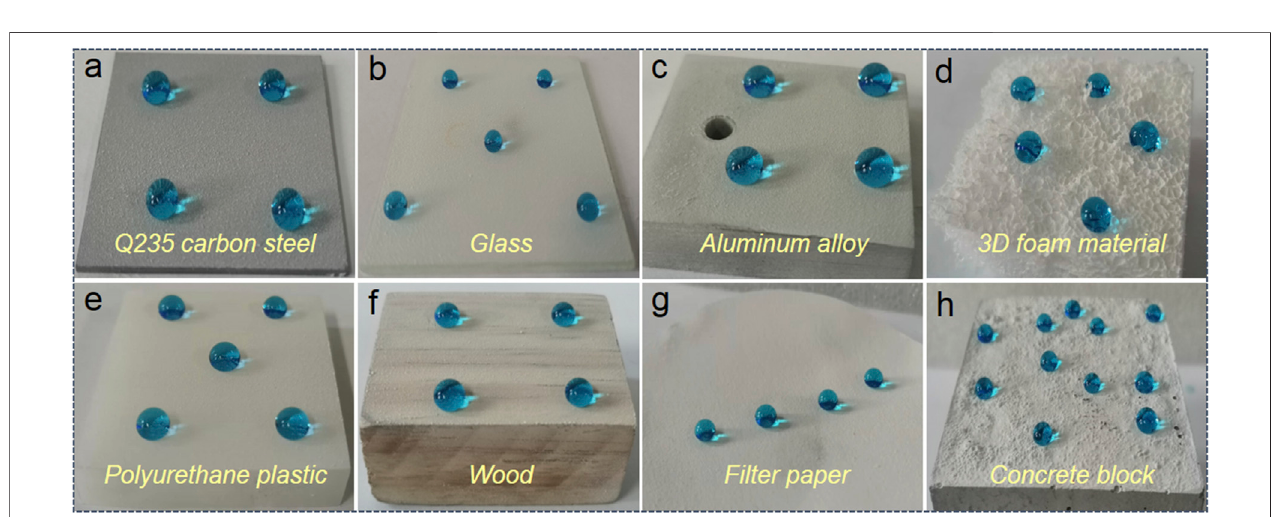
Frontiers in Materials |